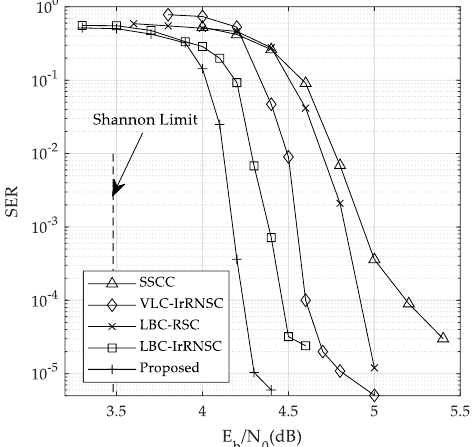
Figure 7. The SER performance of different systems over the AWGN channel